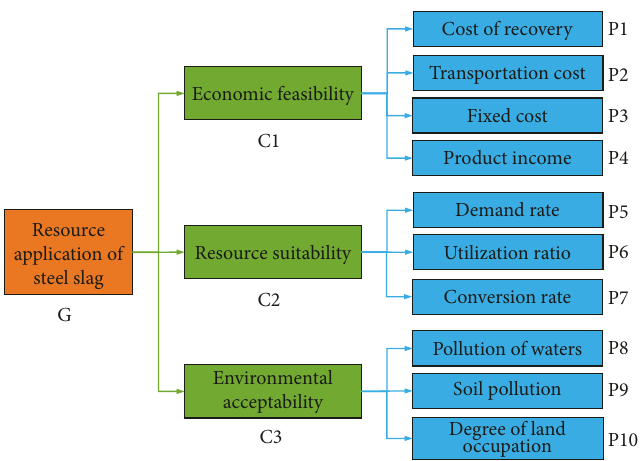
Figure 12: The evaluation index system for resource utilization of steel